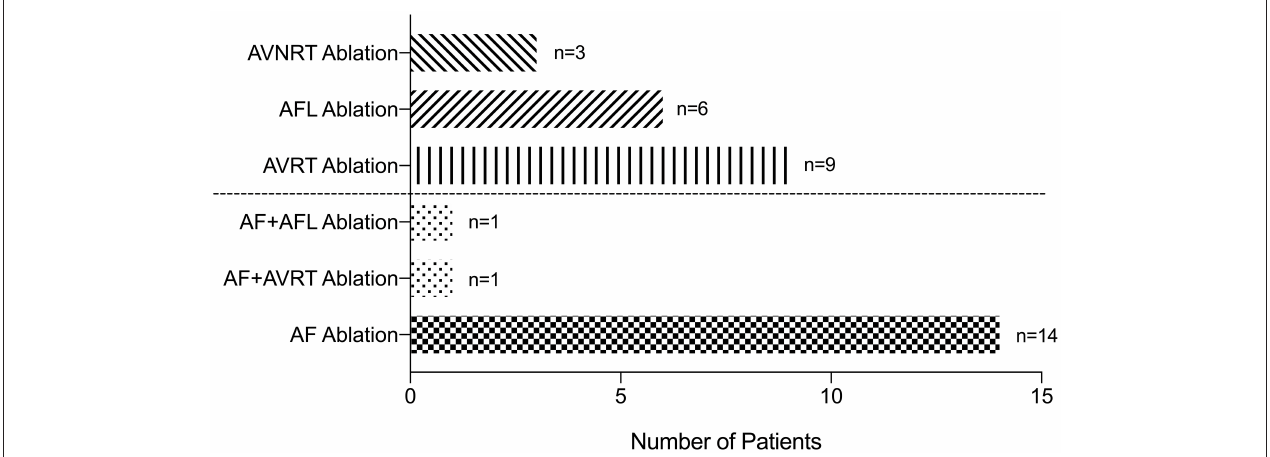
FIGURE 2 | Patients underwent successful ablation. AF, atrial fibrillation; AFL, atrial flutter; AT, atrial tachycardia; AVRT, atrioventricular reentrant tachycardia; AVNRT, atrioventricular nodal reentrant tachycardia.